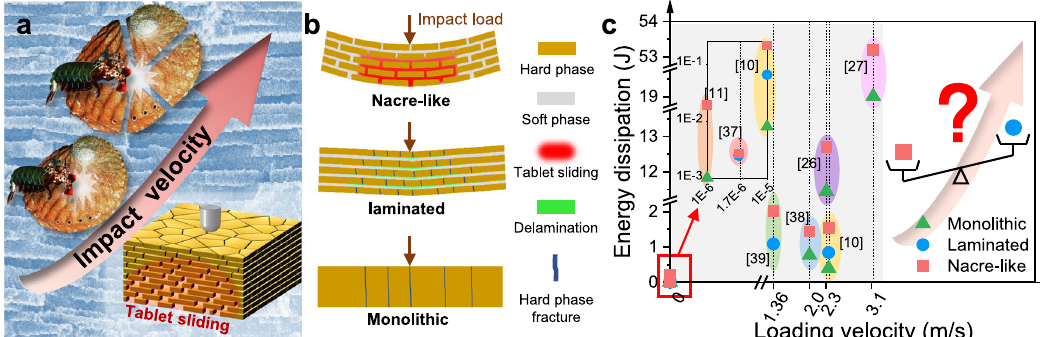
Fig.1|Thevelocity-dependentimpactresistanceofnacre-likestructures.a The schematic illustration of nacre from abalone shells smashed by predators with the increase of the impact velocity, where tablet sliding over large volume is key to impact-energy dissipation. b The schematic of energy-dissipation mechanisms of the nacre-like structure, laminated structure and monolithic structure under